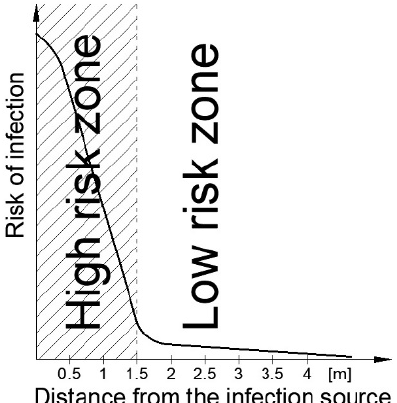
Figure 1. Relationship between infection risk and physical distancing [20].